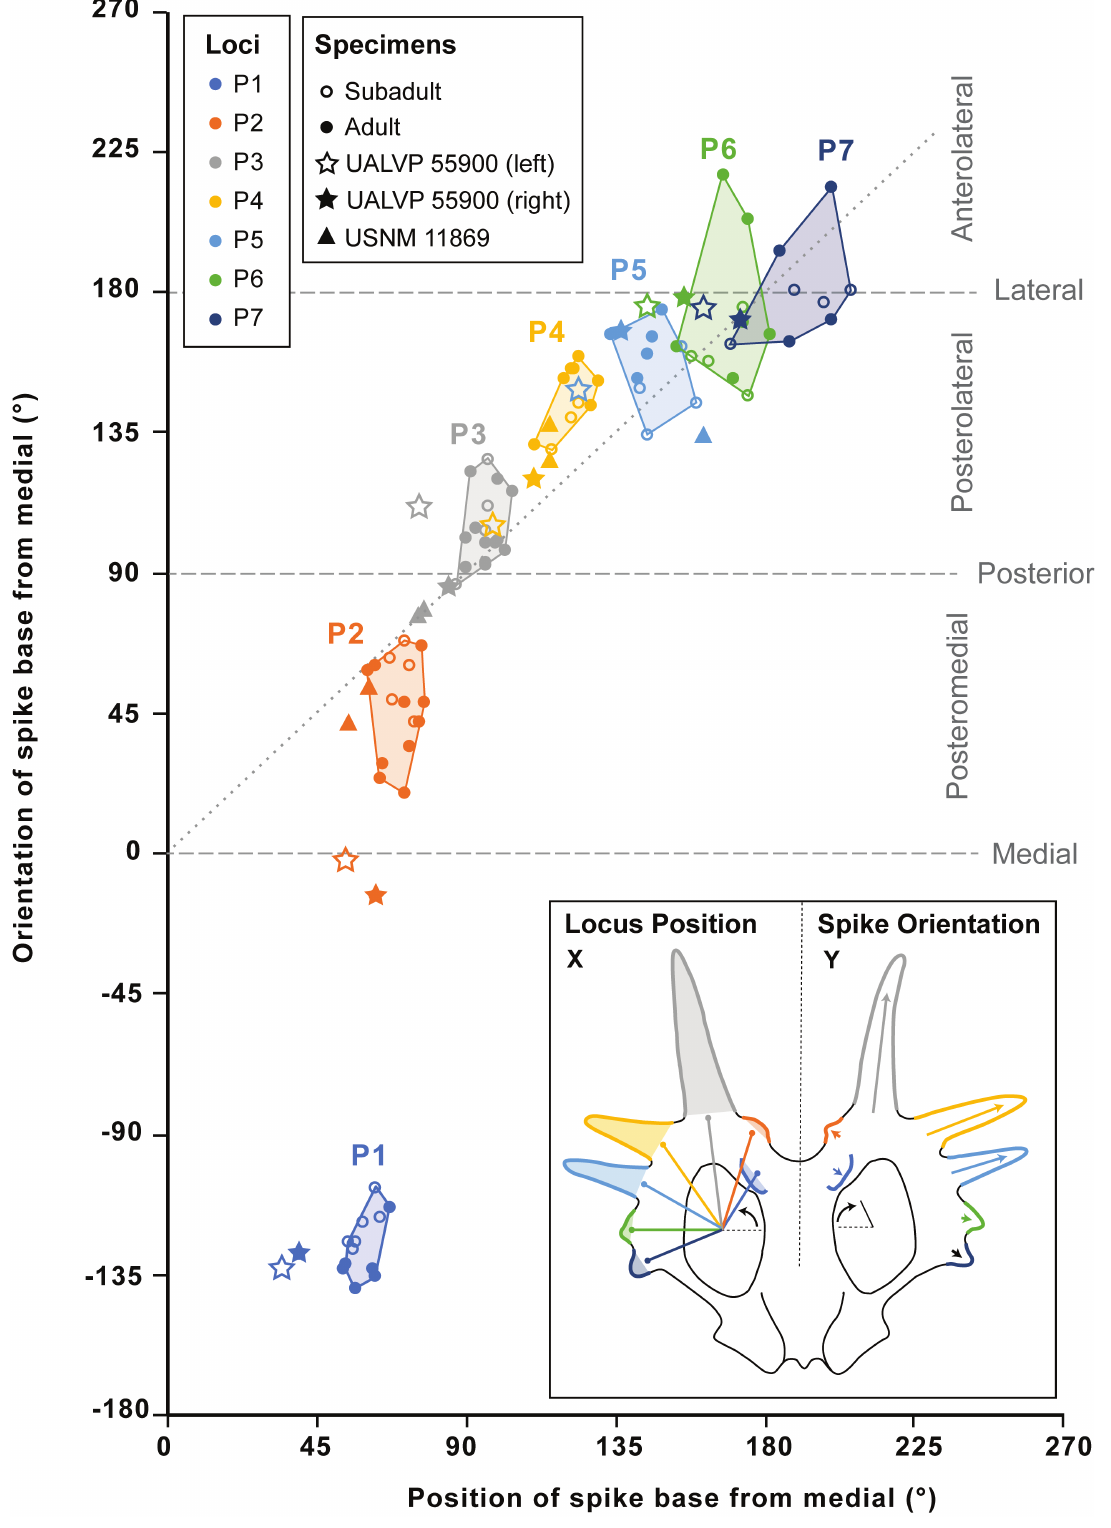
Figure 11. Graph depicting the orientation of each parietal process as a function of its radial position along the margin of the parietal. Serial homologous loci (i.e. P1−P7) are differentiated by colour and clusters are highlighted with convex hulls (excluding UALVP 55900, and USNM 11869). Horizontal dashed lines represent medial, posterior and lateral orientations. Diagonal dotted line represents 1:1 correlation in base opposition and process orientation. Immature specimens indicated with open circles, adult specimens indicated with solid circles, UALVP 55900 indicated with stars and USNM 11869 indicated by